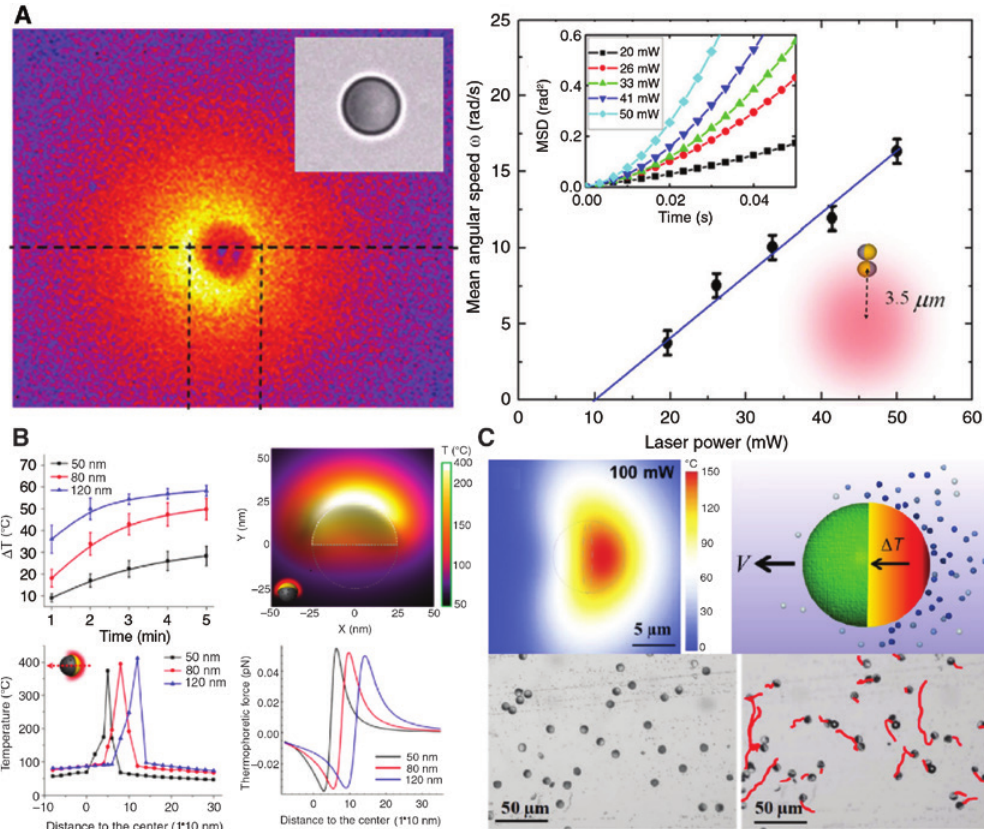
Figure 3: Micro/nanomotors with photothermal-effect propulsion. (A) Theoretical photos of the photothermal effect and the motion speed with respect to the NIR laser power of Au-silica Janus particles [82]. Copyright 2010, American Physical Society. (B) The measured temperature changes with respect to time and the calculated temperature distribution of a type of Janus mesoporous silica